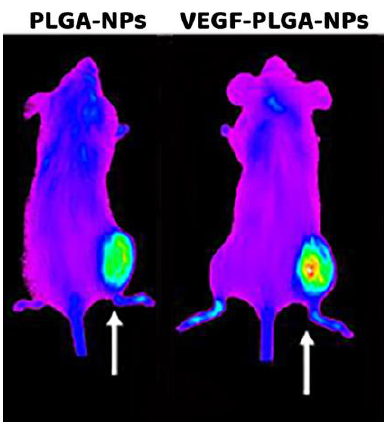
Figure 6. Whole body images of two mice bearing a syngeneic J744a.1 tumor in the right thigh and acquired 24 h post-injection (p.i.) of native PLGA-NPs (left) and VEGF-PLGA-NPs (right).